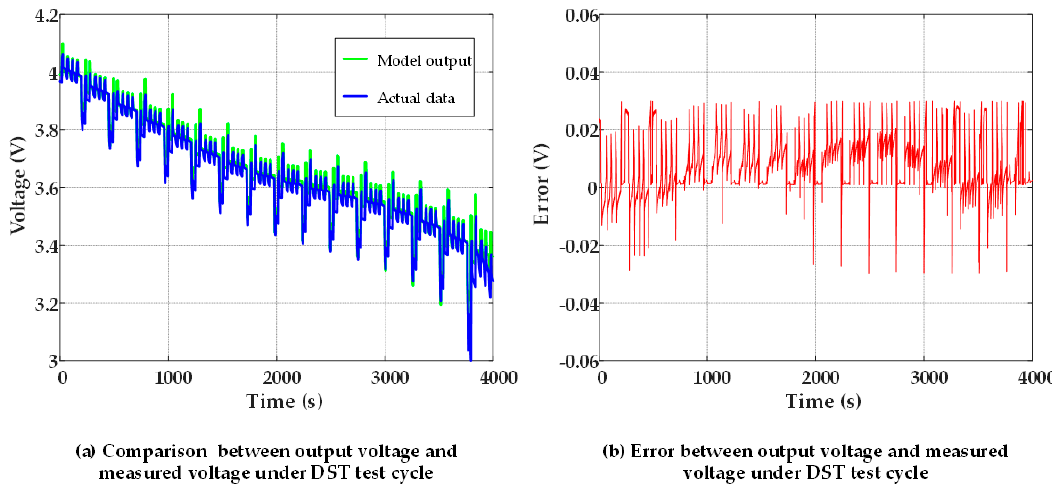
Figure 5. DST working condition verification of the dual-polarization model (DPM).